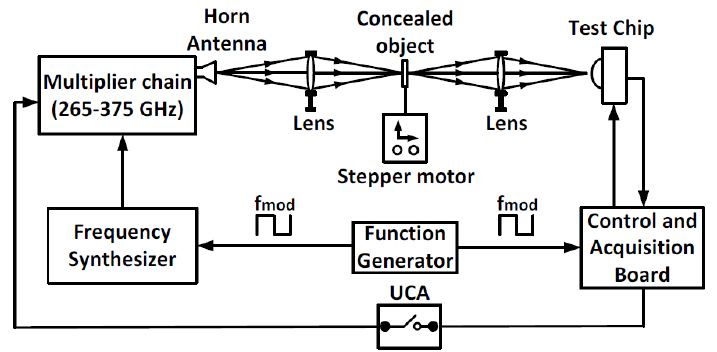
Figure 20. Block diagram of the THz imaging setup.